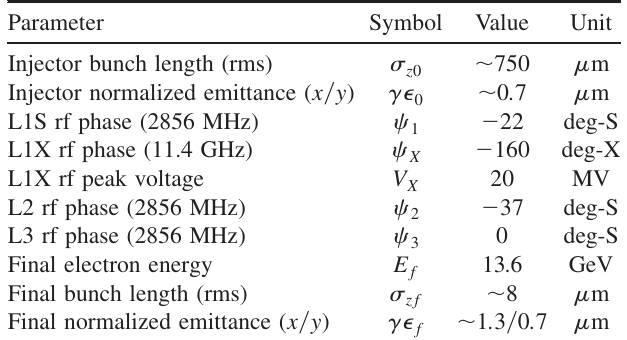
TABLE I. Nominal measured beam and linac parameters for 250-pC bunch charge operation.